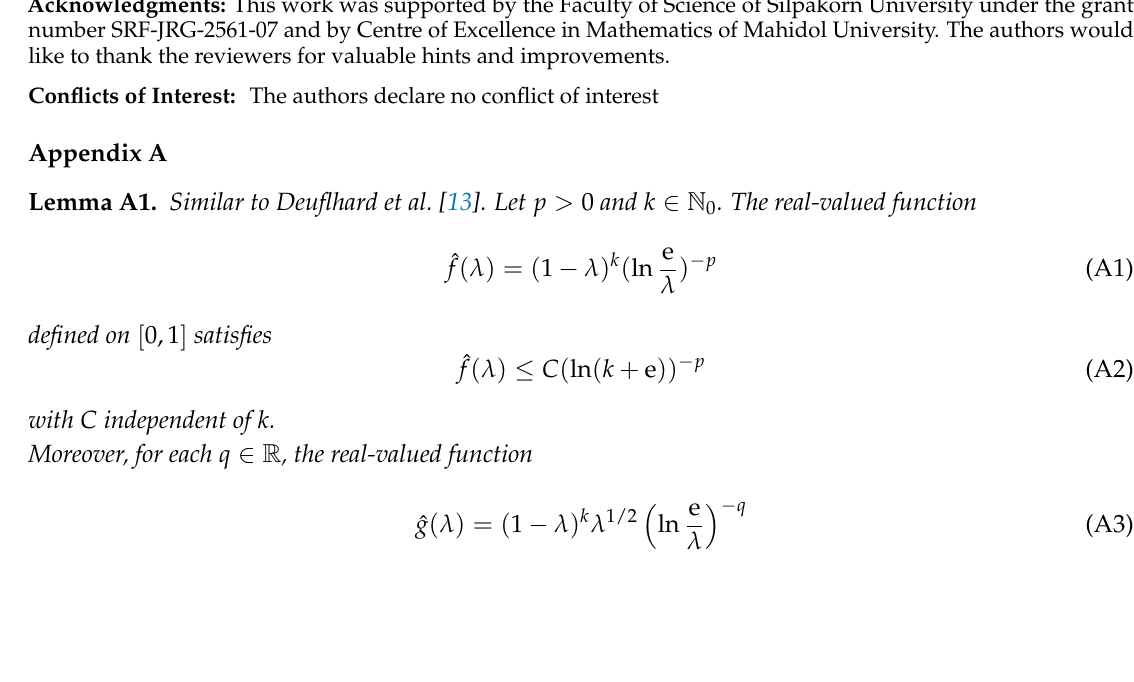
sin ( s ) . The parameter α n in Equation (71) is −